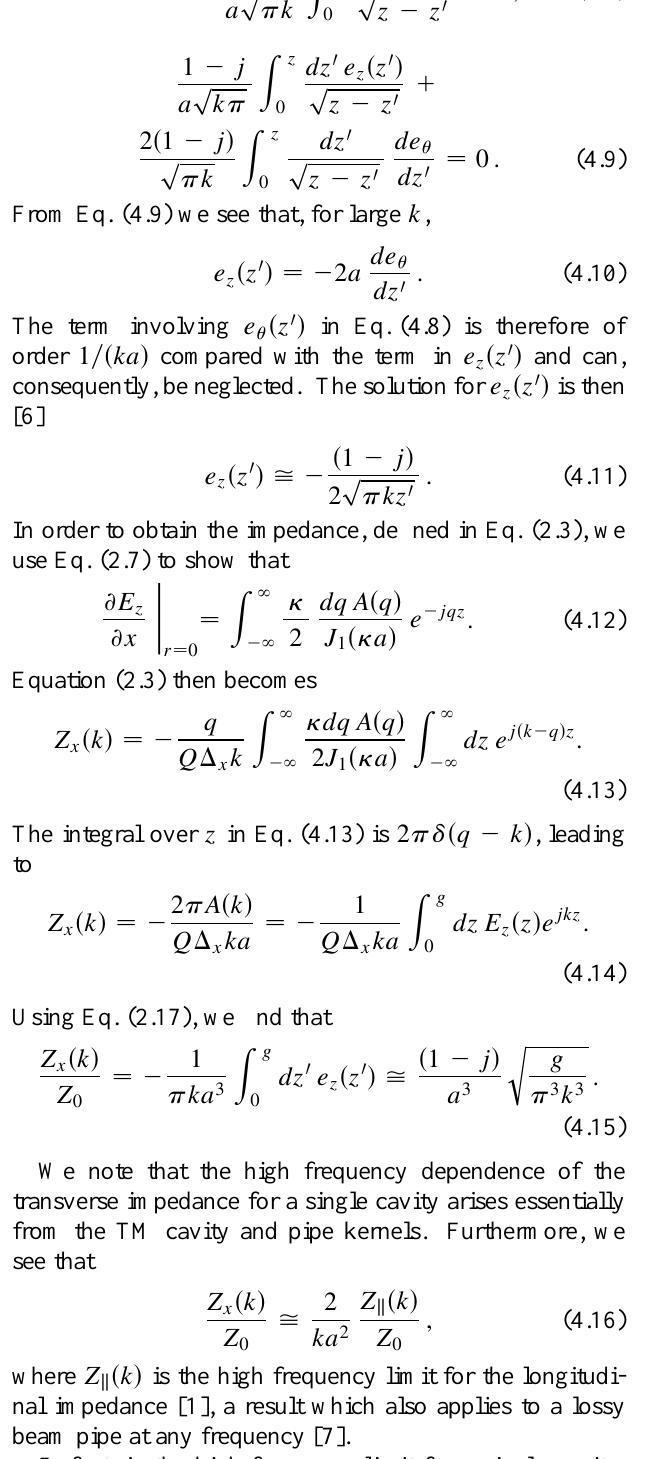
FIG. 2. The layout of geometry for a periodic array of